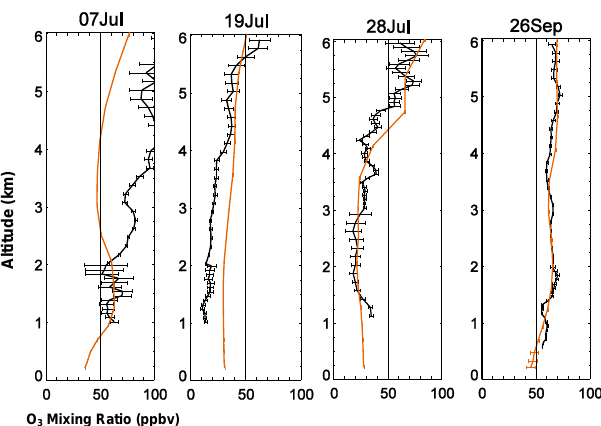
Figure 5. Same as Fig. 4 but for 7, 19, and 28 July, and 26 Septem- ber in